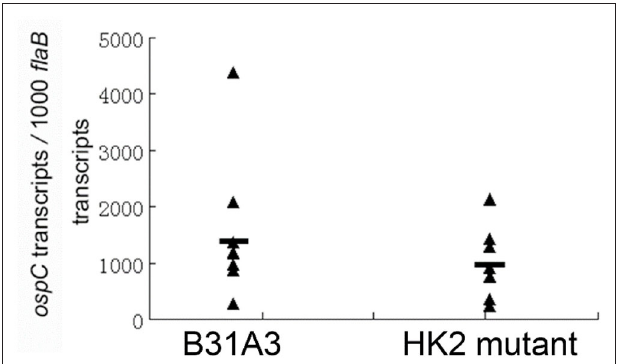
FIGURE 2 | qRT-PCR analyses of spirochetes during tick feeding. Flat I. scapularis nymphs infected with either the wild-type strain B31A3 or the hk2 mutant were fed on naive C3H/HeN mice, and engorged nymphs were subjected to qPCR analyses. Seven ticks were examined for each group, and each data point was from one nymph. The level of ospC expression were nornalized with the level of flaB transcripts of B. burgdorferi . No significant difference was observed between the two groups.